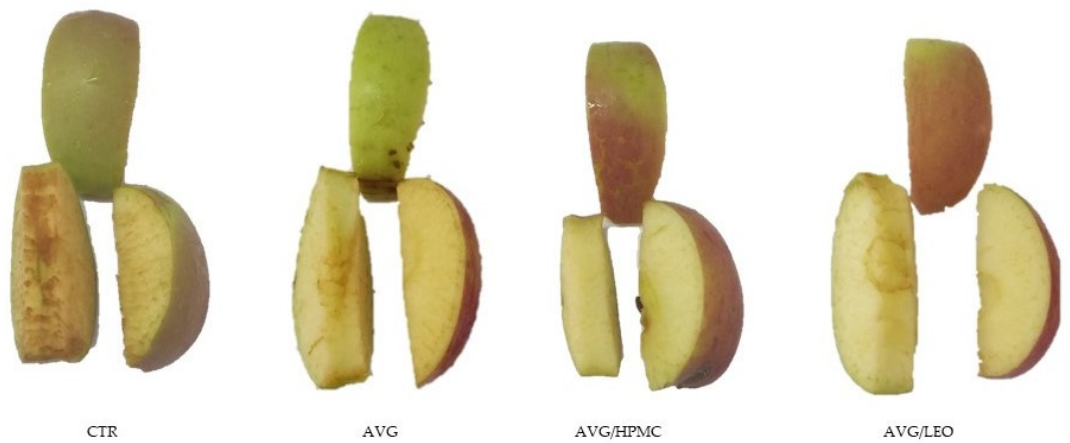
Figure 1. Visual aspect of treated and untreated fresh − cut ‘Fuji’ apple after 9 days of cold storage at 4° ± 1 °C and 90% ± 5% RH.